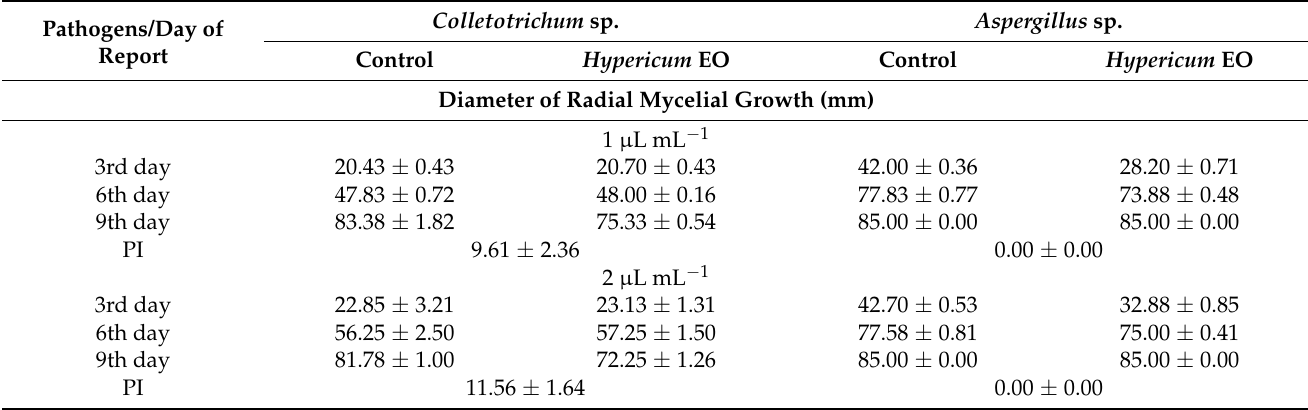
Table 8. Inhibitory effect of commercial Hypericum perforatum essential oils on plant pathogenic fungi (mean ± SD).